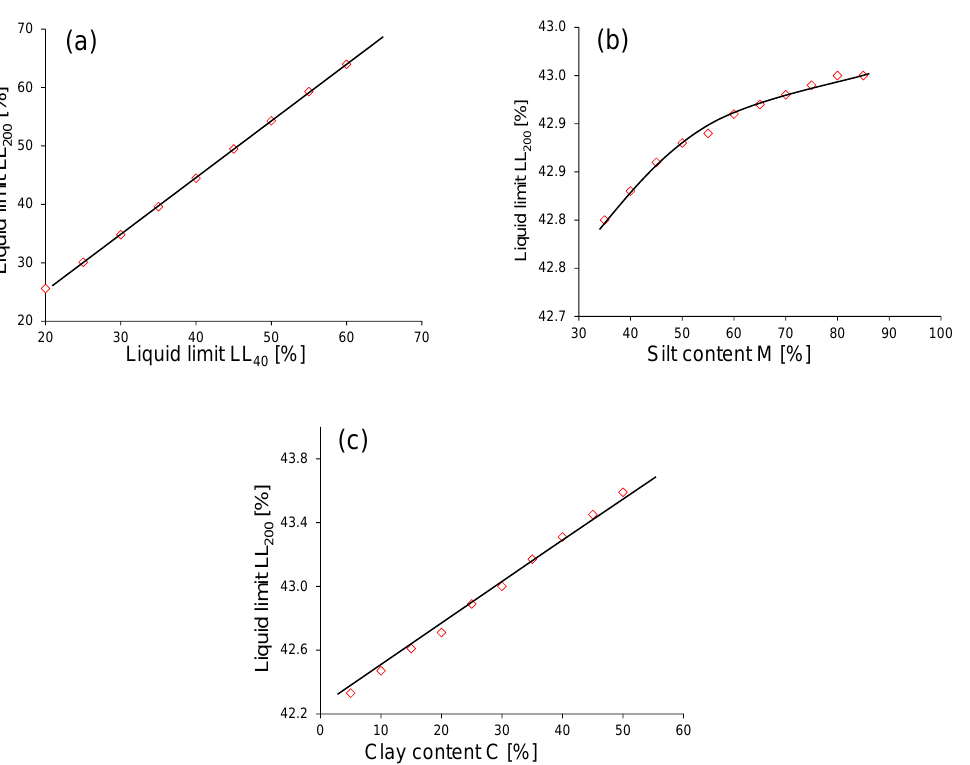
Figure 8. Parametric analysis of input parameters; ( a ) variation of liquid limit LL 200 with varying liquid limit based on # 40 sieve passing material [%]; ( b ) variation of liquid limit LL 200 with varying silt content M [%]; ( c ) variation of liquid limit LL 200 with varying clay content C [%].